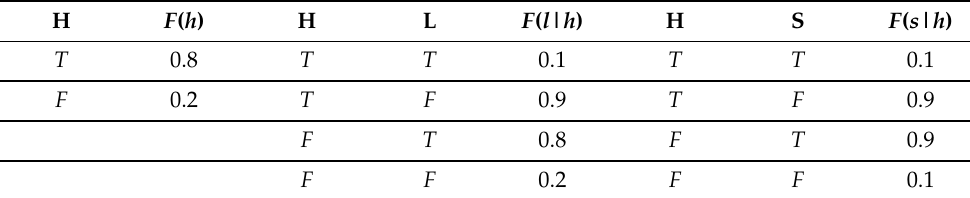
Table 3. Initial